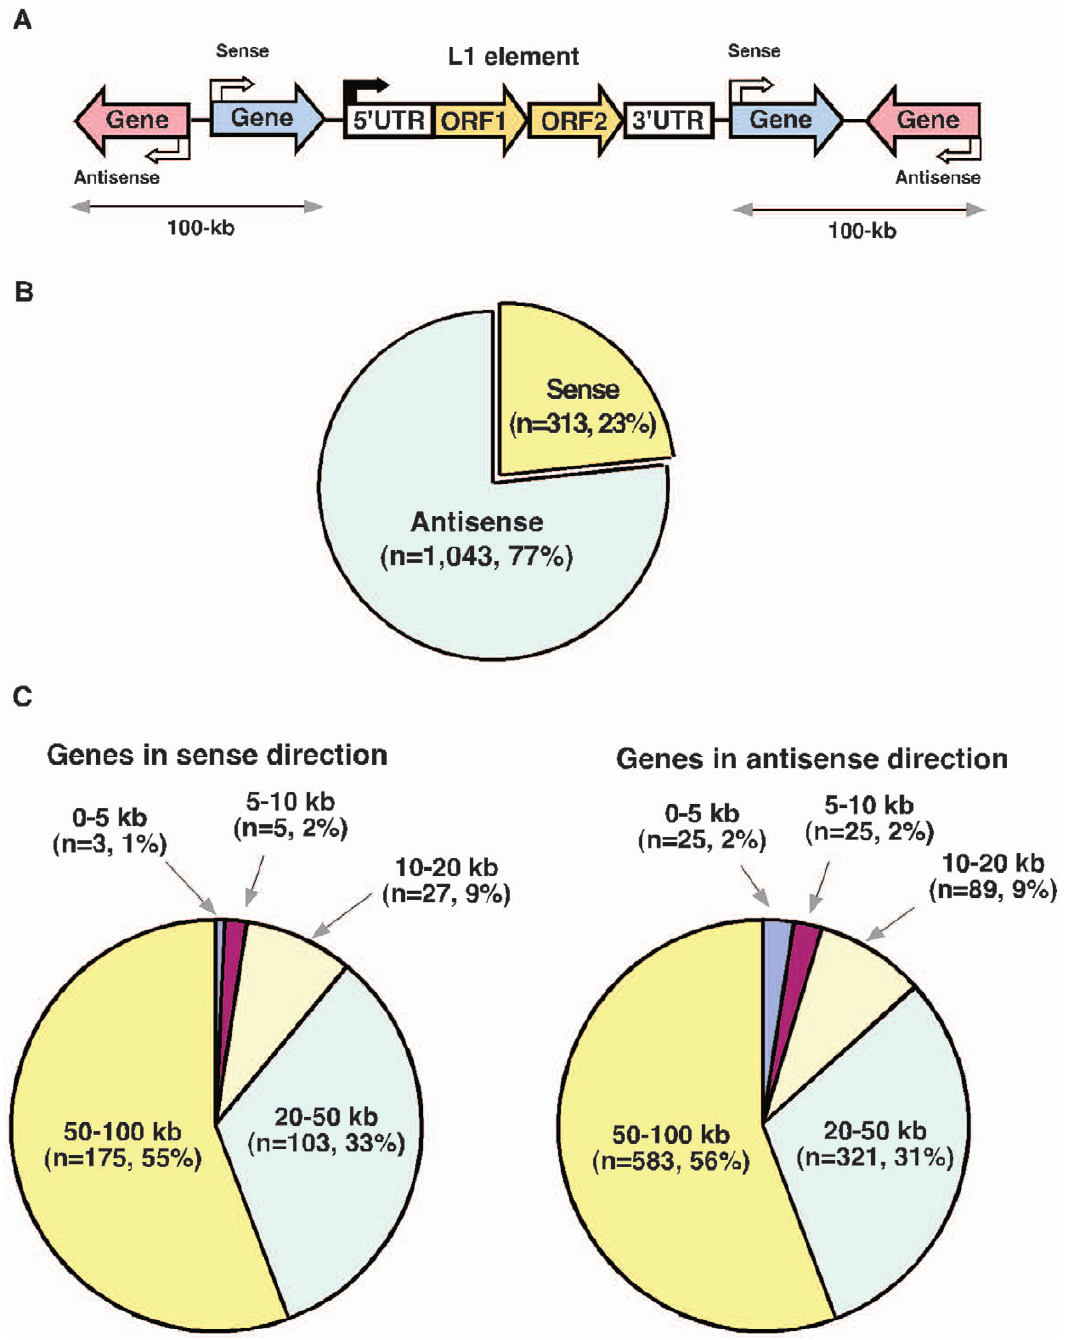
sense or antisense orientation with respect to L1 elements. ( C ) Distribution profiles of neighboring genes located in terms of distance from the L1 elements (0–5 kb, 5–10 kb, 10–20 kb, 20–50 kb, and 50–100 kb) in sense (left panel) and antisense (right panel) orientations. ‘n’ represents the number of L1 elements.